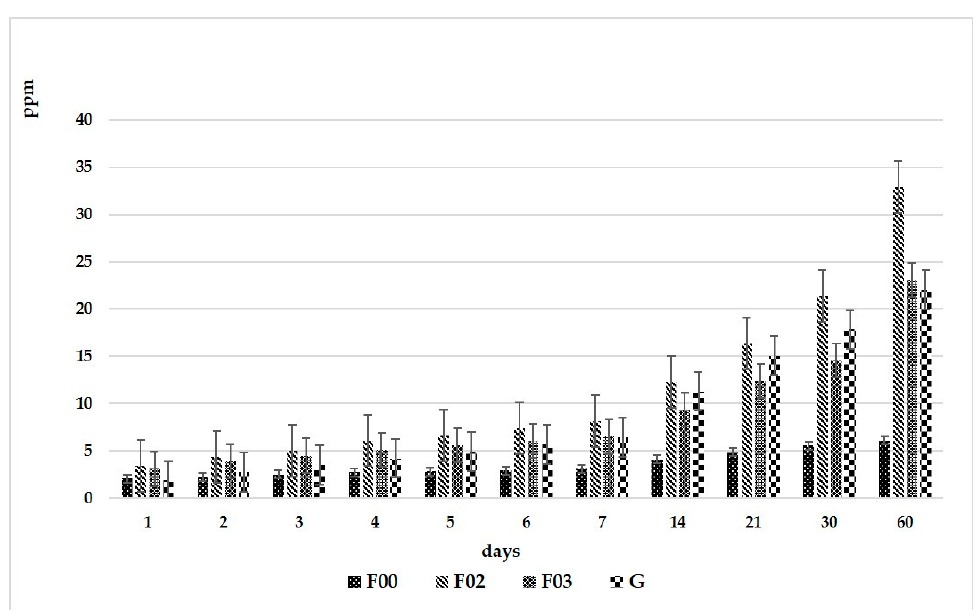
Figure 1. Total fluoride release over the 60 days investigation period .